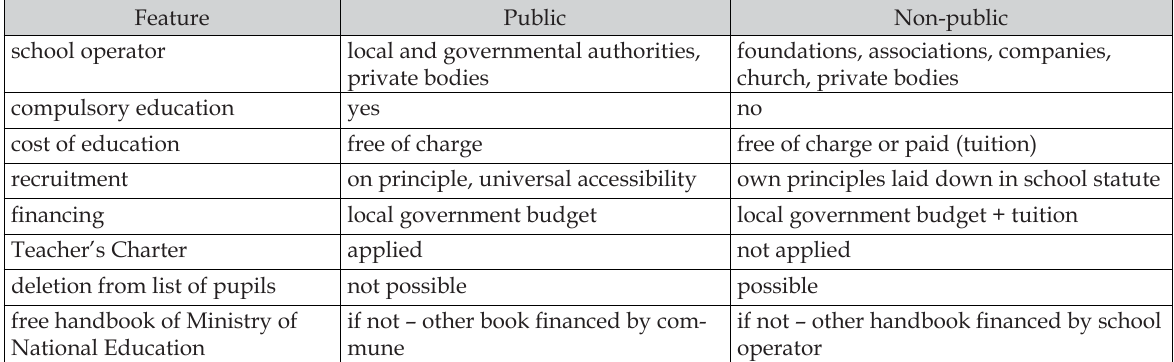
Table 3. Comparison of public and non-public education – main